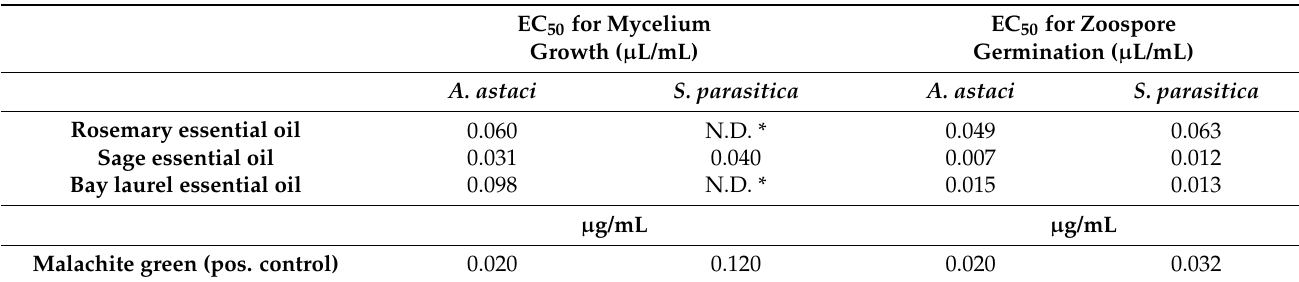
Table 1. EC 50 values for inhibition of mycelial growth and zoospore germination of A. astaci and S. parasitica by rosemary, sage, and bay laurel essential